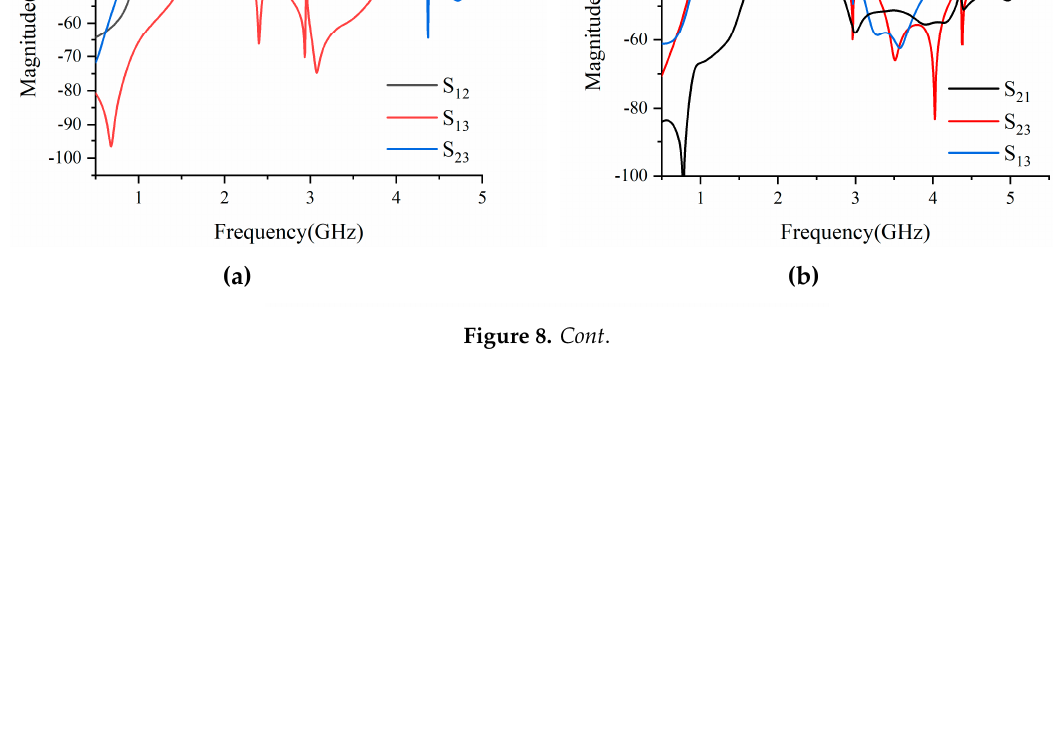
Figure 8. Summary of the simulated port isolations of the reconfigurable filtering antenna: ( a ) UWB state (D1 on, D2 and D3 off); ( b ) 2.4 GHz narrowband (D2 on, D1 and D3 off); and ( c ) 3.5 GHz narrowband (D3 on, D1 and D2 off). The measured realized gains between the proposed reconfigurable filtering antenna and the original UWB antenna are compared in Figure 9. Figure 9 shows that the gains of the proposed filtering antenna are slightly lower than the original UWB antenna, which is mainly caused by insertion loss of additional filter structures and PIN diodes. Figure 9. Comparison of the measured realized gains between the proposed antenna and the UWB antenna.